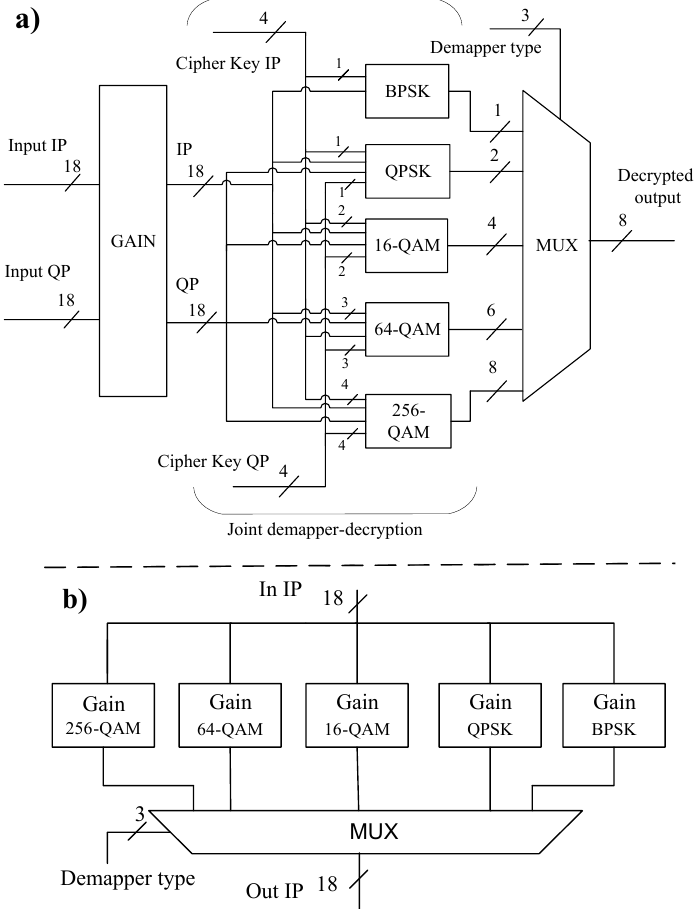
Figure 7. ( a ) Hardware architecture of the decryption; ( b ) gain block